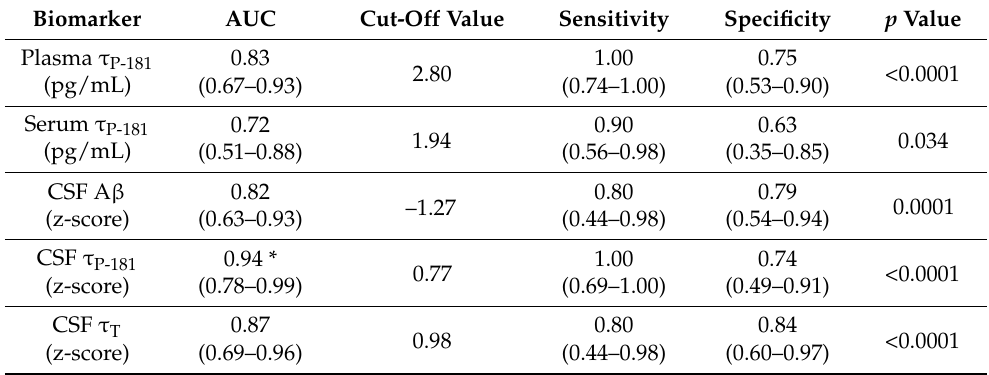
AUC: Area under the ROC curve. p values indicate the level of significance as compared to an AUC of 0.5. Values in parentheses indicate the 95% confidence interval. * p = 0.04 vs. serum τ P-181